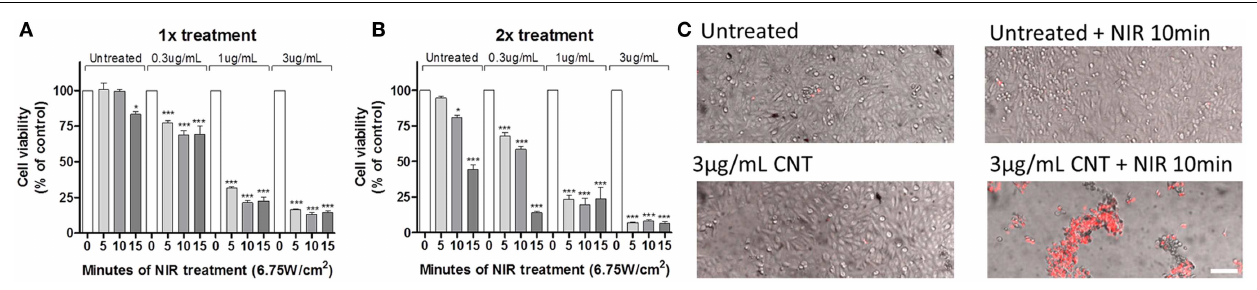
FIGURE 3 |The sequential treatment of CNTs and NIR induces lethal hyperthermia . U251 glioma cells were treated with CNTs (0.3, 1, and 3 µ g/mL) and NIR once (A) or twice (B) for 5, 10, or 15min; after 72h, the MTT cell viability assay showed that exposure to NIR (6.75W/cm 2 ) reduced